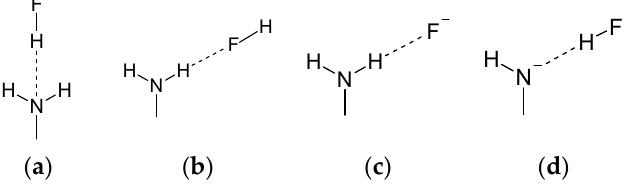
Scheme 2. Schematic presentation of the studied H-bonded interactions of the amino